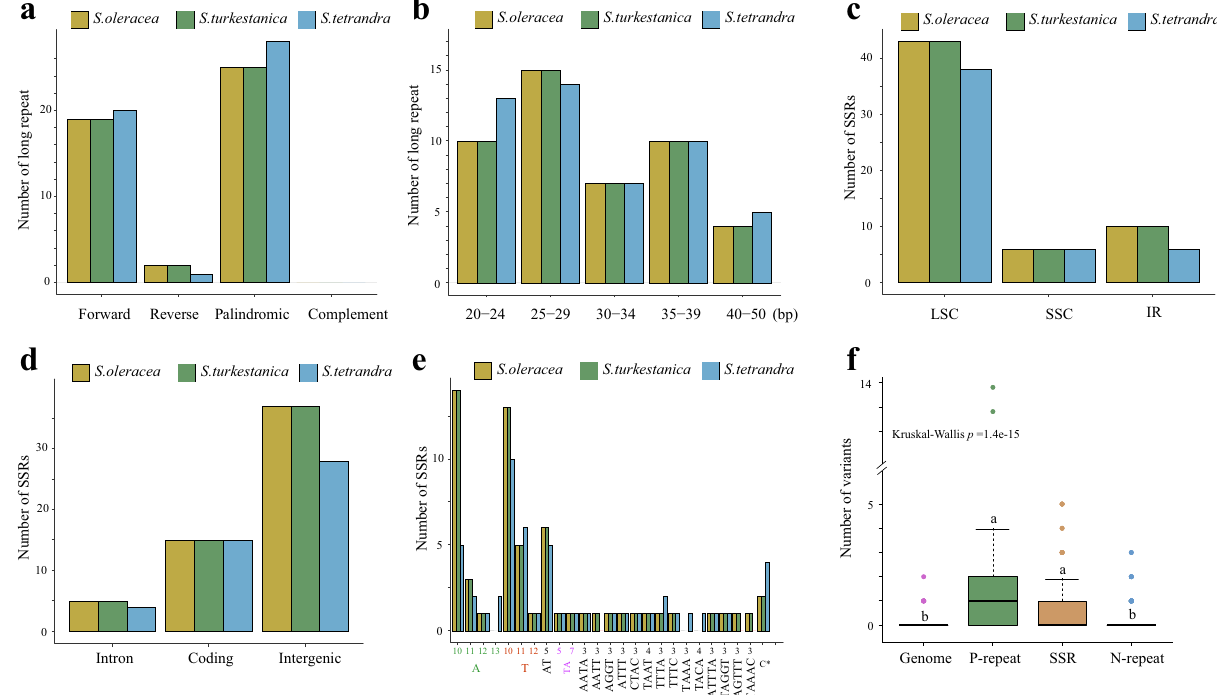
Figure 5. Repeat sequences in the chloroplast genomes of three Spinacia species. ( a ) Number of different long- repeat types and ( b ) length distribution in the Spinacia species. (c) Distribution of SSRs in the LSC, SSC, and IR regions, as well as ( d ) intron, coding, and intergenic regions. ( e ) Analysis of SSRs for different lengths of repeat (bp) and repeated sequences. ( f ) Comparison of variant (SNPs and Indels) numbers between the repeat regions and equivalently sized regions randomly selected from the chloroplast genome. The repeat regions indicate upstream and downstream 50-bp repeats. The genome represents the 50 regions randomly sampled from the chloroplast genome (including upstream and downstream 50-bp repeats). The P-repeat refers to polymorphic long-repeat regions, whereas N-repeat refers to non-polymorphic long-repeat regions. The different letters on the top of the boxplot indicate significant differences (Kruskal–Wallis test, P <